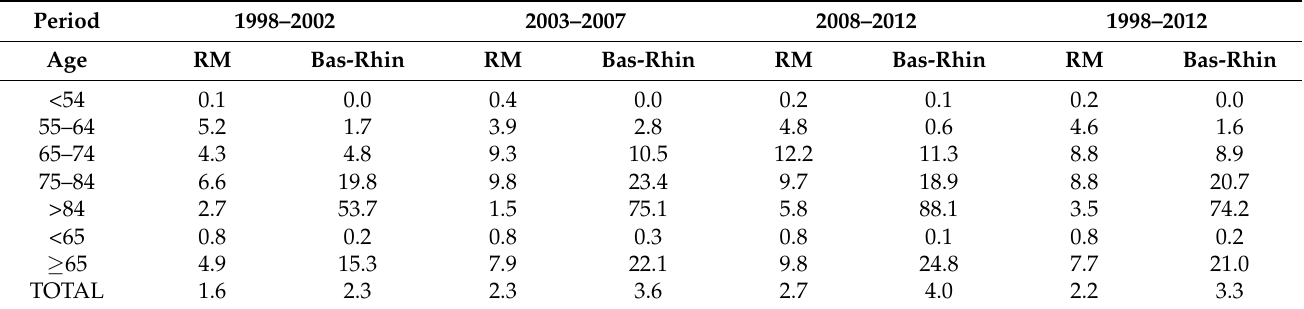
Table 2. Crude incidence rates/100,000 person-years for type II endometrial carcinoma, by age and period in the Region of Murcia (RM) and Bas-Rhin area,